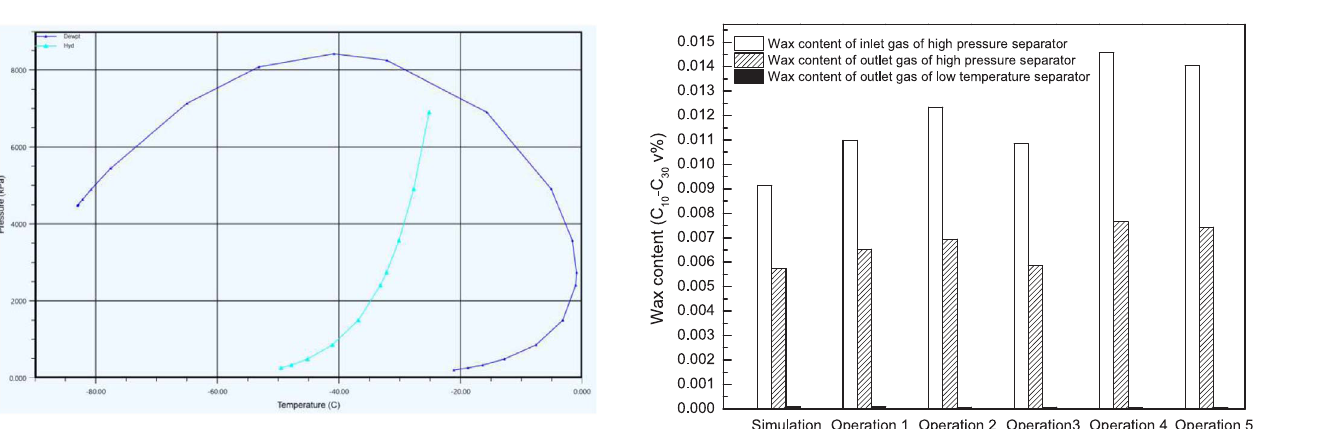
Fig. 15. The comparison of wax content between simulation and operation.